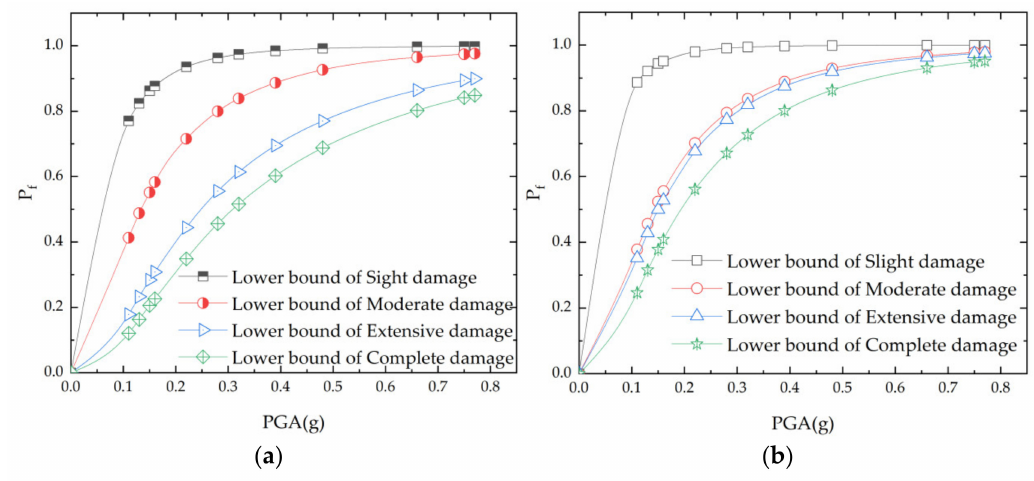
Figure 9. ( a ) Fragility curves of the water stop; ( b ) fragility curves of the pier.